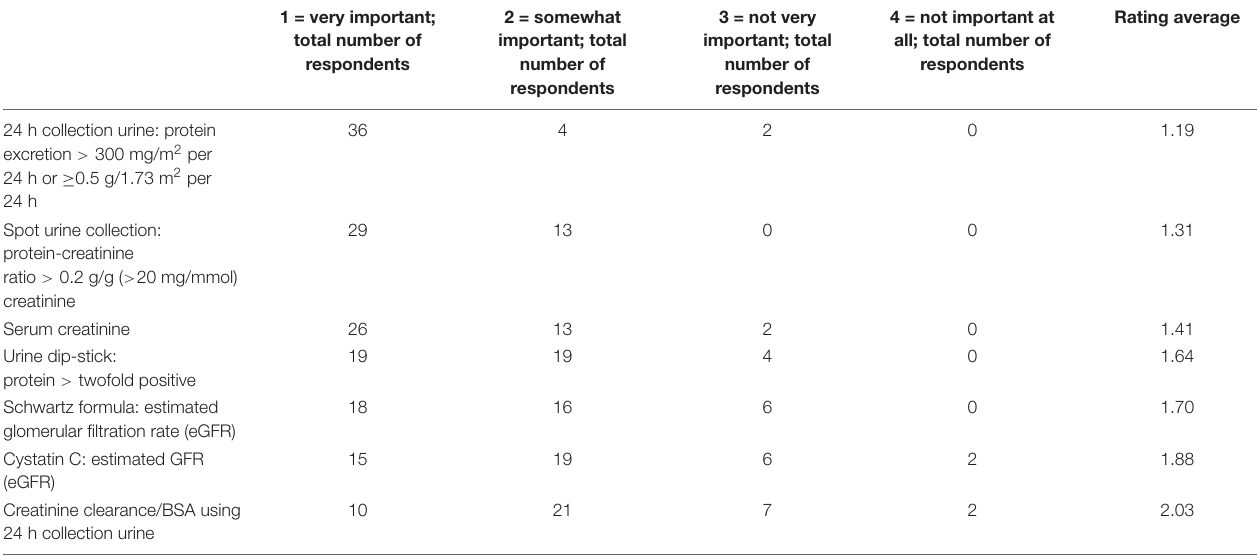
TABLE 2 | Laboratory parameters in terms of their importance in assessing the extent of LN (answers by Likert scale: 1 = very important, 2 = somewhat important, 3 = not very important, 4 = not important at all; with rating average of respondents).